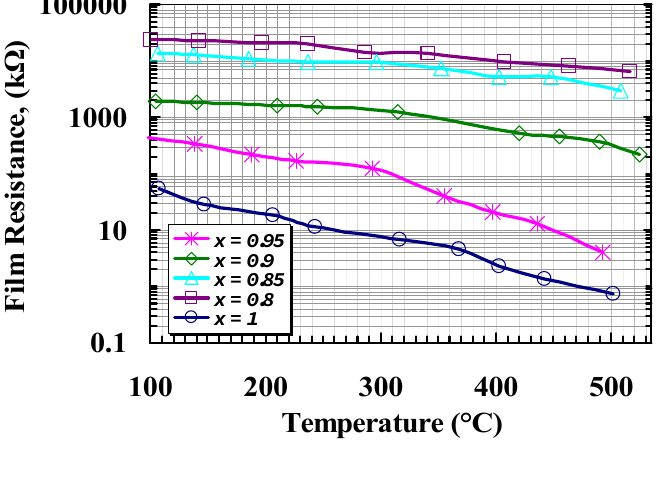
Figure 8. Sensor resistance versus sensor temperature for all